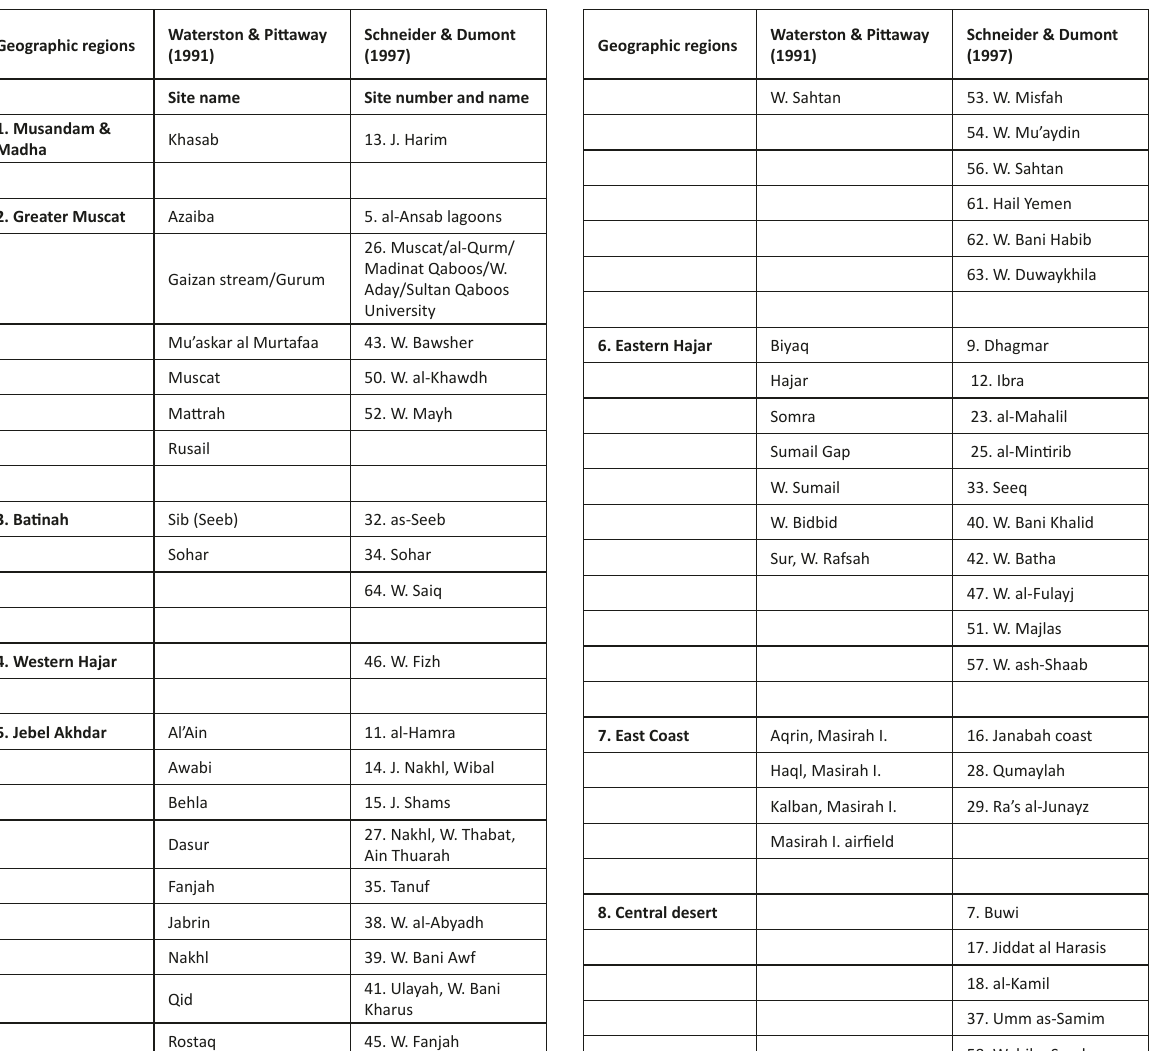
Table 1. Specimen collection sites of Waterston & Pittaway (1991) and Schneider & Dumont (1997) in northern and central Oman organised by geographic regions of the present paper. I. = Island, J. = Jebel (mountain, spelt ‘Jabal’ in Schneider & Dumont 1997), W. = Wadi (valley). Spellings of site names are as in their